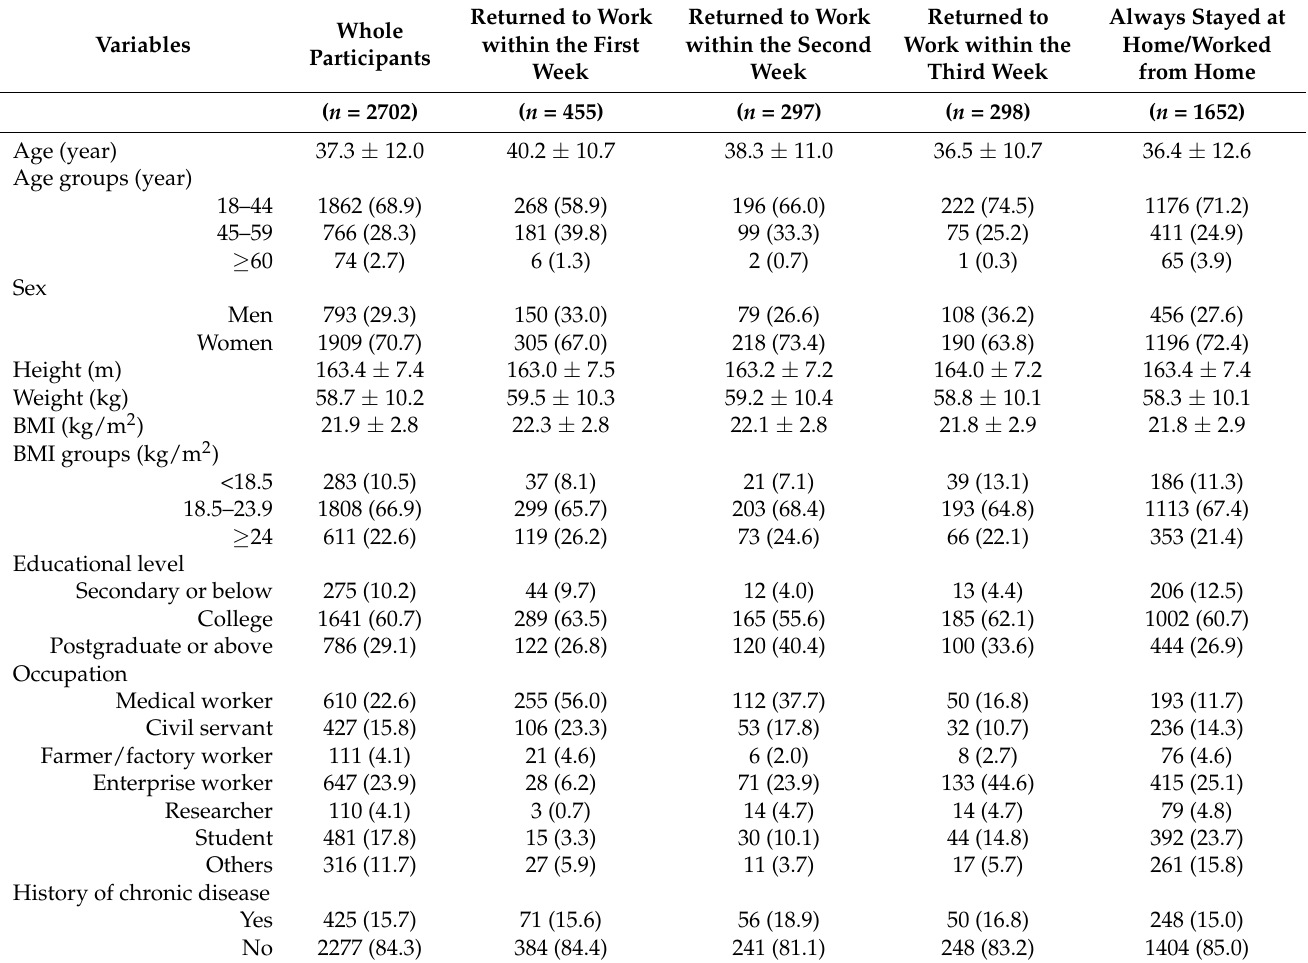
Table 1. Participants ´ general characteristics and anthropometrics 1